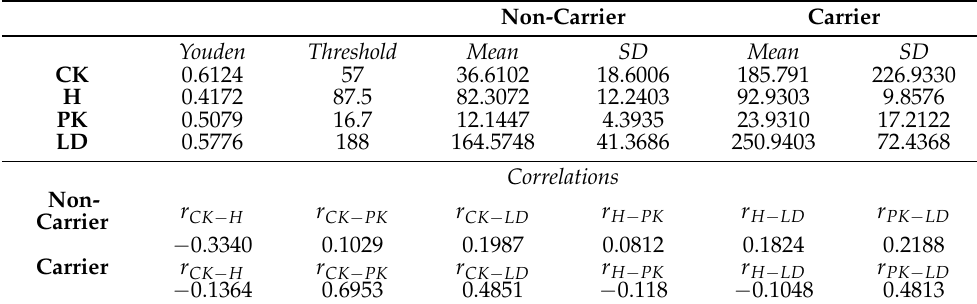
Table 18. DMD dataset